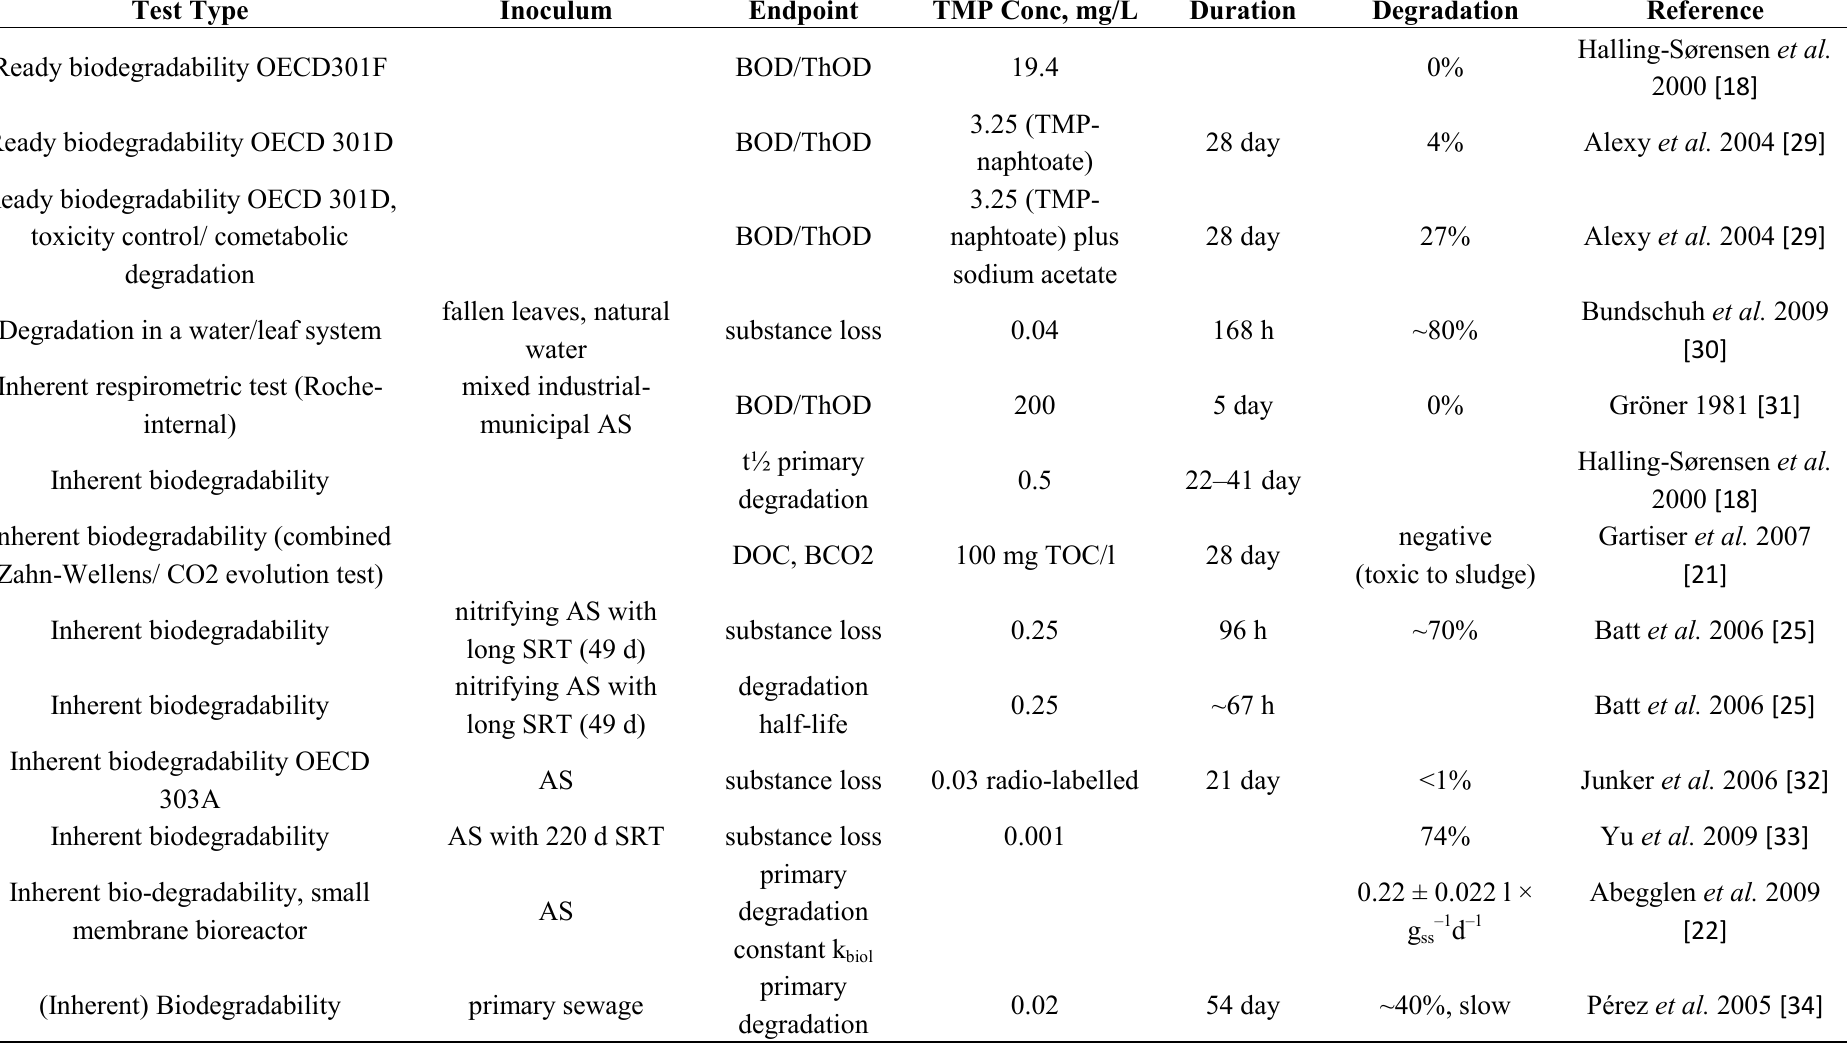
Table A2. Biodegradability and elimination of